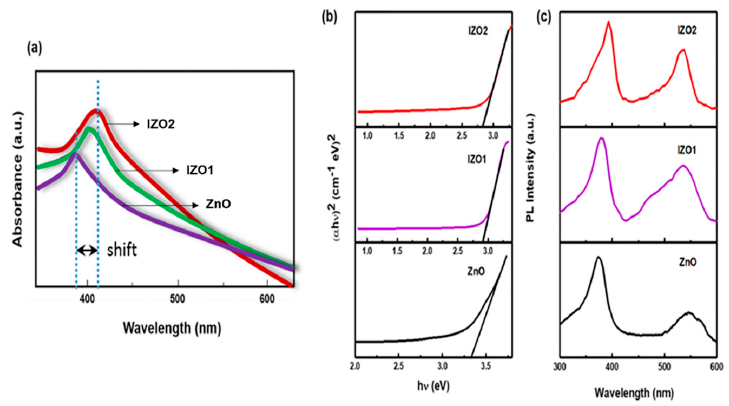
Figure 17. Optical characterization results of IZO samples: ( a ) Absorbance spectra of ZnO, IZO1 and IZO2. ( b ) Tauc’s plot of ( α h ν ) 2 versus energy h ν . ( c ) PL spectra of ZnO, IZO1 and IZO2. Reproduced with permission from Ref. [93]; published by Elsevier, 2019.